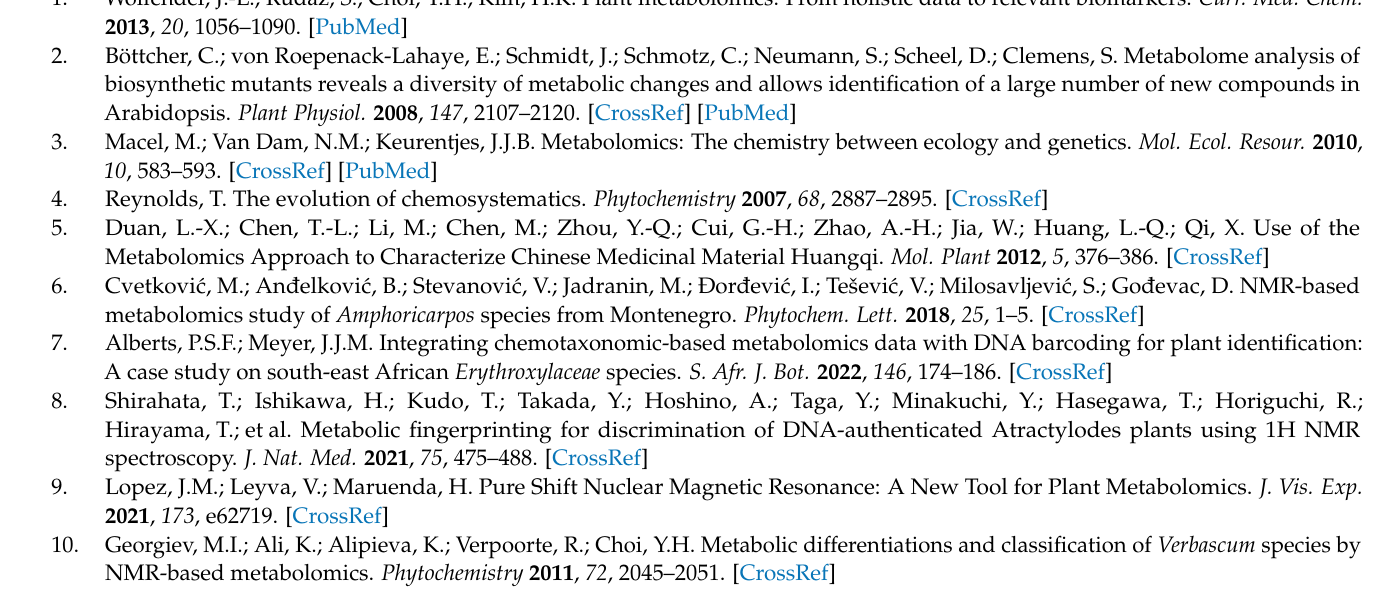
E. species; Table S5. Validation parameters of CV-ANOVA test from OPLS-DA model of E. cyparissias vs. remaining E. species; Table S6. Validation parameters of CV-ANOVA test from OPLS-DA model of E. maculata vs. remaining E. species. Table S7. PCA and OPLS-DA model parameters of tested Euphorbia